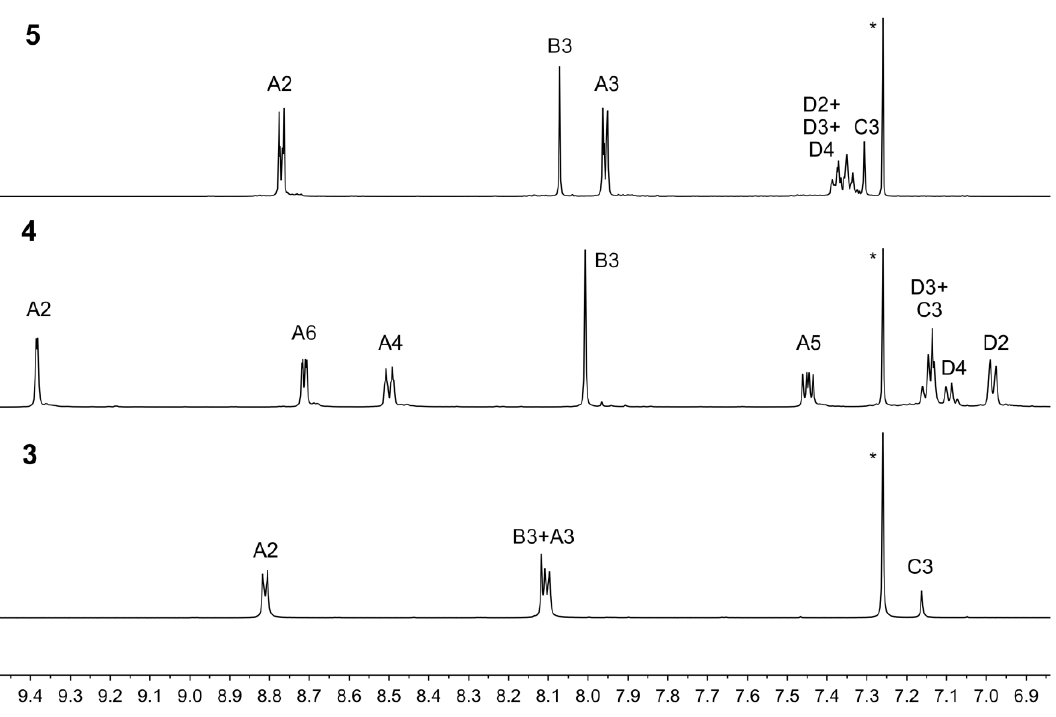
Figure 1. Aromatic regions of the 1 H NMR spectra of ligands 3 – 5 (500 MHz, CDCl 3 , 298 K). See Scheme 4 for atom labels. * = residual CHCl 3 .